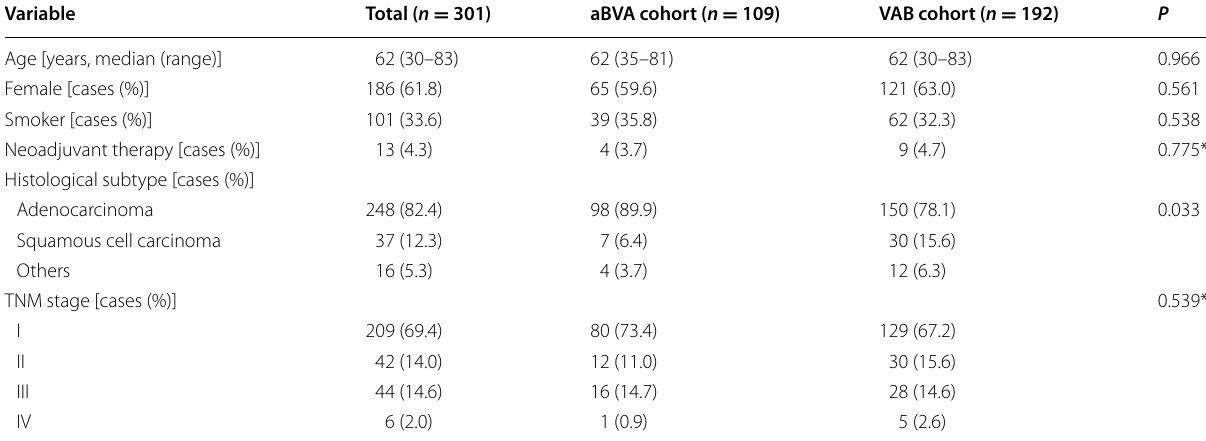
aBVA right upper lobectomy (RUL) with the dissecting order of the posterior ascending arterial branch [a], followed by the right upper bronchus [B] and pulmonary vessels [VA]; VAB RUL with the dissecting order of the right upper pulmonary veins and arteries [VA], followed by the right upper bronchus [B]